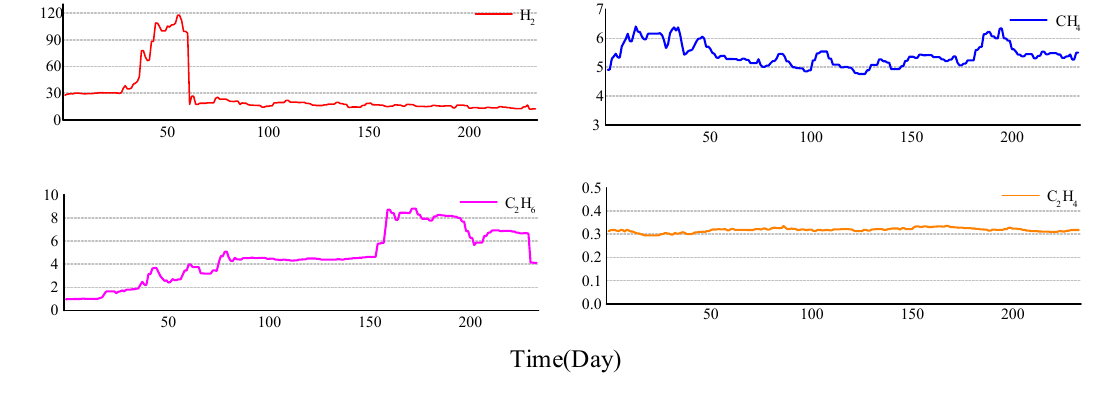
Figure 8. The content of gas (uL/L).